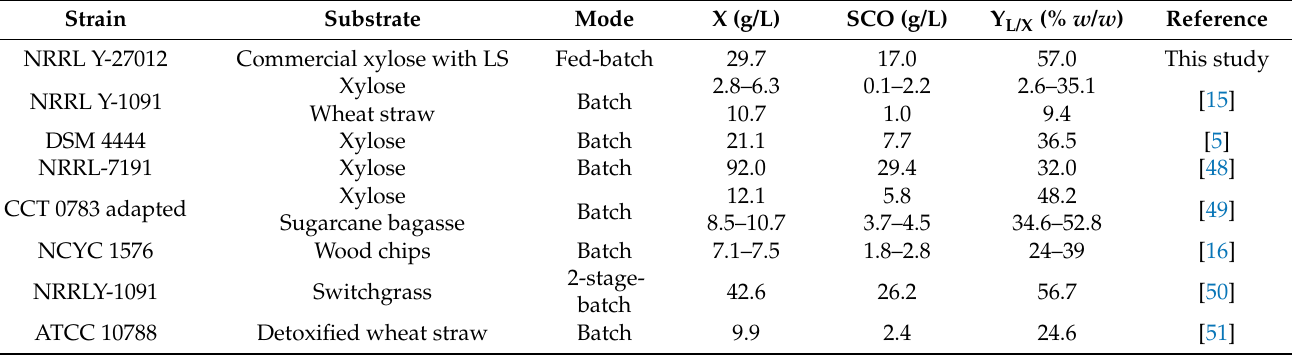
Table 3. Literature-cited publications focusing on R. toruloides strains that were cultivated on xylose- rich media, synthetic or derived from renewable lignocellulosic